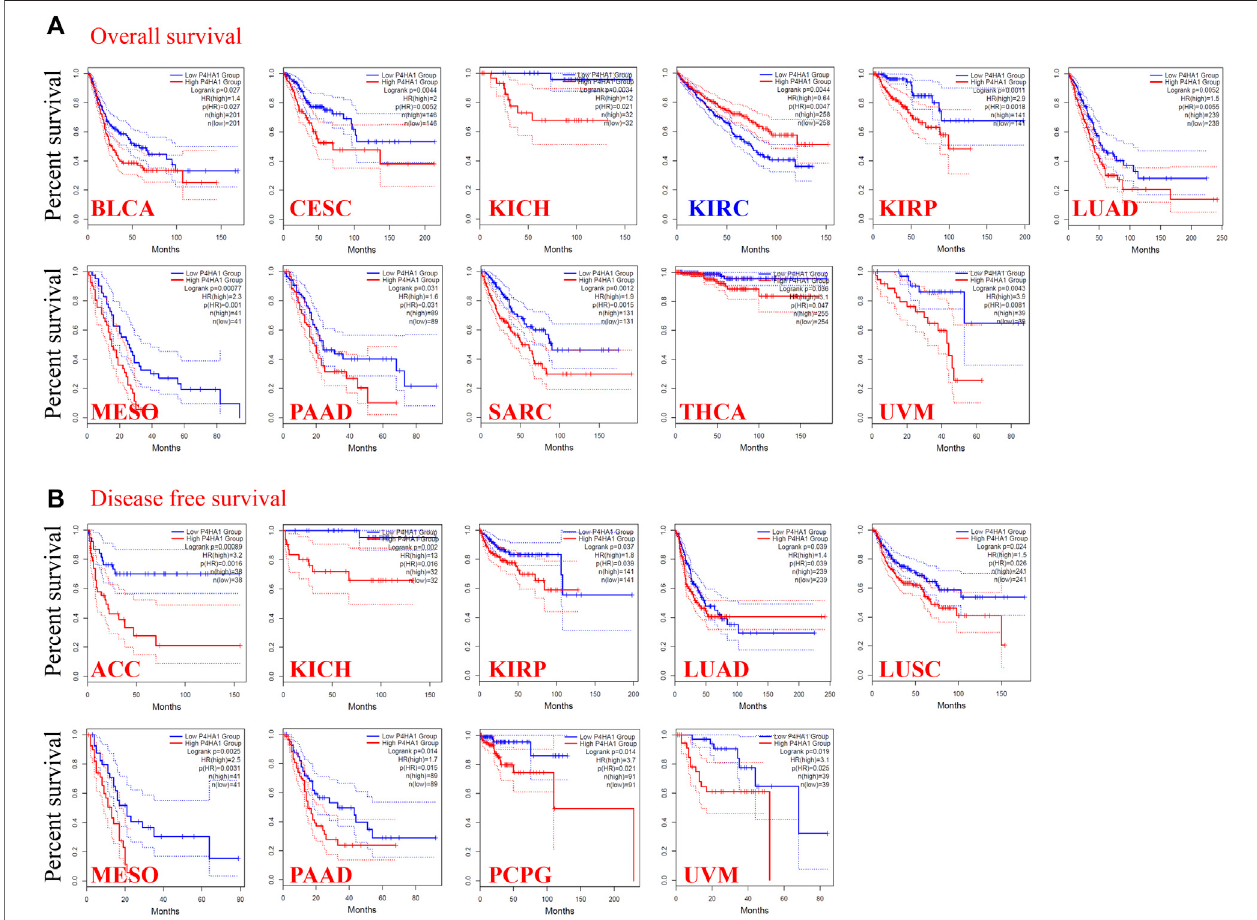
FIGURE2| CorrelationbetweentheP4HA1expressionlevelandsurvivalprognosisofdifferenttumorsintheTCGAdataset. (A,B) WeusedtheGEPIA2tool(http:// gepia.cancer-pku.cn/) to conduct overall survival (OS) (A) and disease-free survival (DFS) (B) analyses of different tumors in TCGA by P4HA1 expression level.